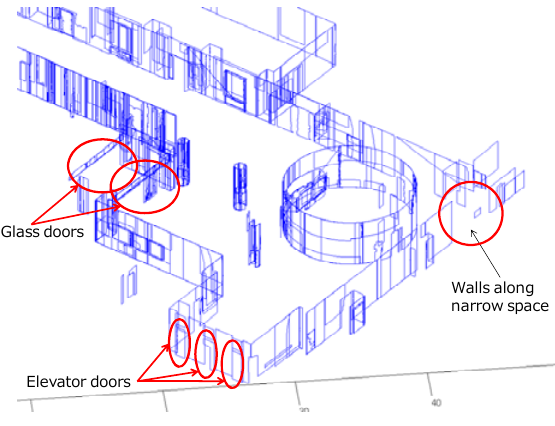
Figure 14. Failures in polygon